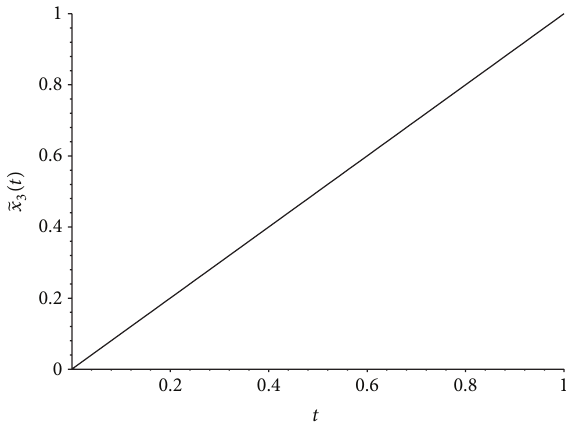
Figure 4: Approximation ̃𝑥 3 (𝑡) to the exact solution 𝑥(𝑡) = 𝑡 of the fractional differential equation (49), obtained from the application of Theorem 7, that is, obtained by solving (53) with 𝑁 = 3